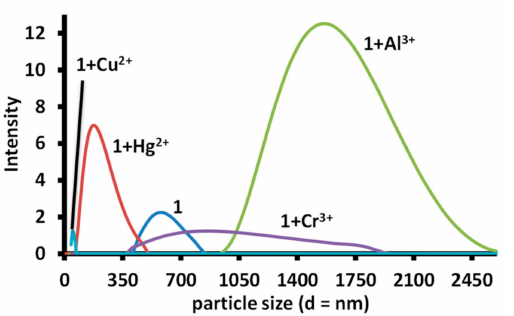
Figure 13. The particle size observed in a solution of 1 , 1 -Hg 2 + (1:1), 1 -Cr 3 + (1:1), 1 -Al 3 + (1:1) and 1 -Cu 2 + (1:1) in water; [ 1 ] = [Hg 2 + ] = [Cr 3 + ] = [Al 3 + ] = [Cu 2 + ] = 1.02 mM.